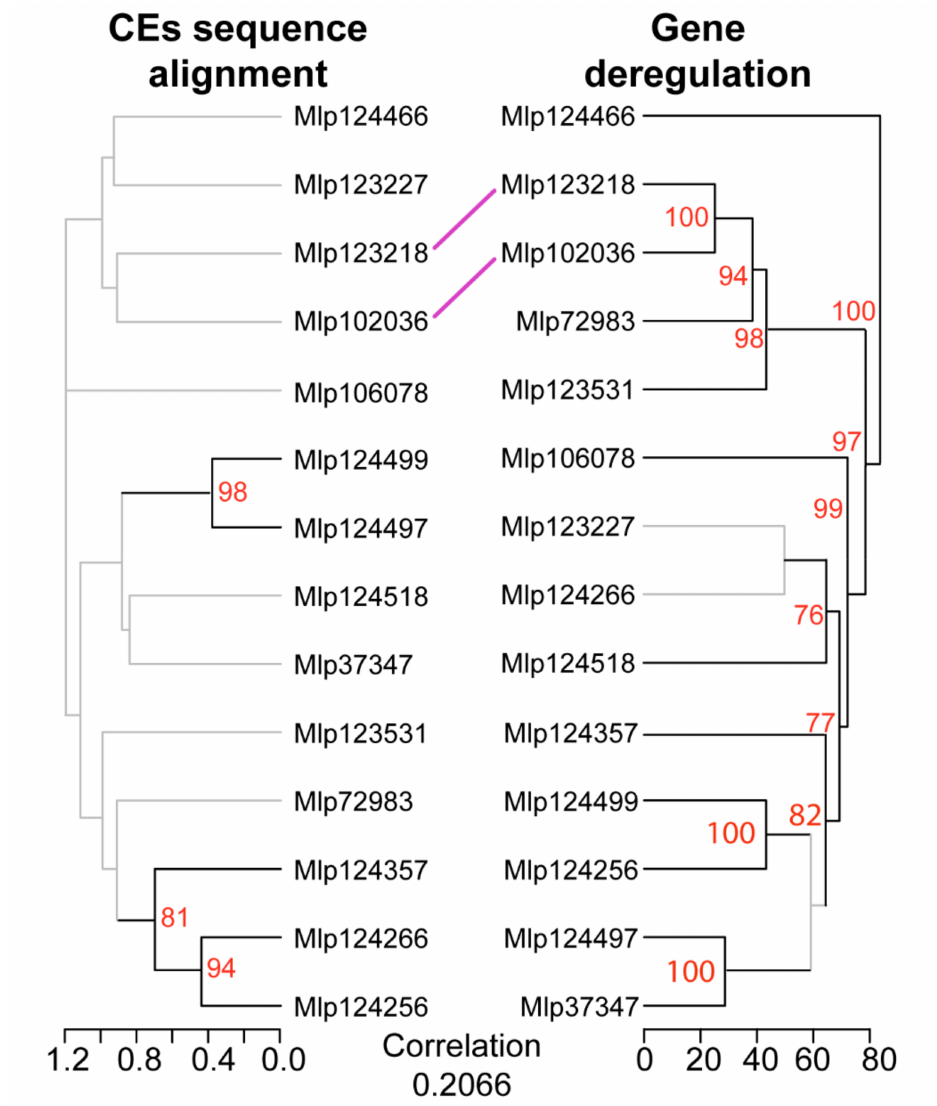
Figure 3. Hierarchical clustering of gene deregulation groups effectors independently of amino acid sequence homology. Comparison between dendrograms based on CE sequence similarity (left, tree computed with UPGMA from Muscle multiple sequence alignment) and on gene deregulation (right, computed with hierarchical clustering from Pearson’s correlation coefficient of gene fold change levels) shows only one cluster shared between the two (central lines) and an overall lack of correlation between the dendrograms (cophenetic correlation in the bottom). Branches with bootstrap support <70% are shown in grey. The underlying data for this figure can be found in the study by dos Santos et al.